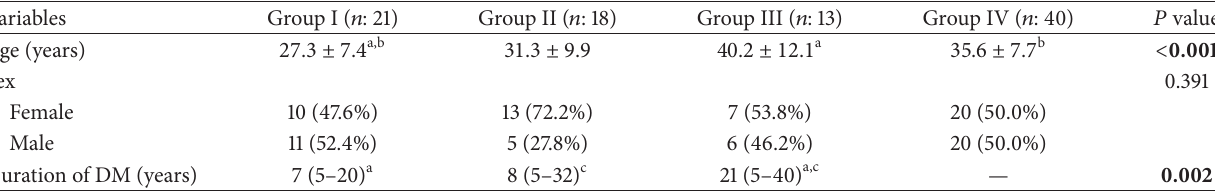
Table 1: Demographic data of the participants.